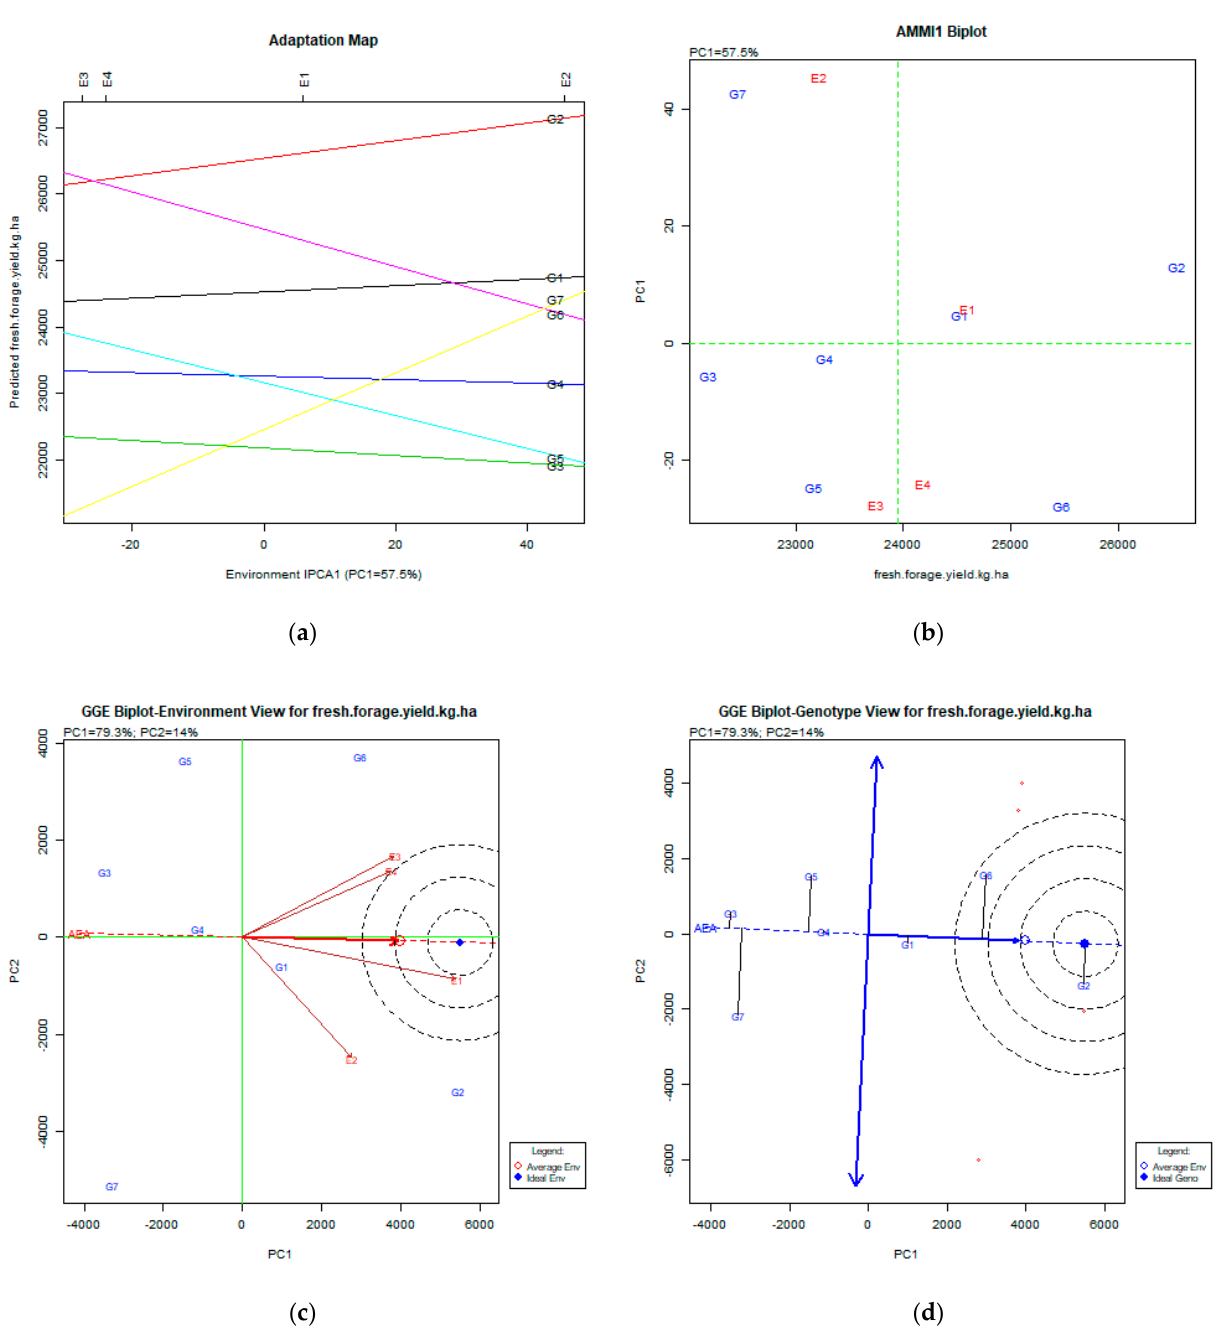
Figure 4. Stability analysis for the trait of fresh forage yield (kg ha − 1 ) based on: ( a ) adaptation map, where the environmental stability of the genotypes is visualized by the X − axis (PC1) and the per- formance of the trait for the genotypes is tested by the Y − axis; ( b ) AMMI1 biplot, where the envi- ronmental stability of the genotypes is visualized by the X − axis (PC1) and the performance of the trait for the genotypes is tested by the Y − axis; ( c ) GGE biplot depicting the environmental stability over time for the desirable genotypes placed near to the ideal environment; ( d ) GGE biplot for gen- otypes depicting the genotypic stability in different environments. The desirable genotypes are those placed near the concentric region of the ideal genotype.